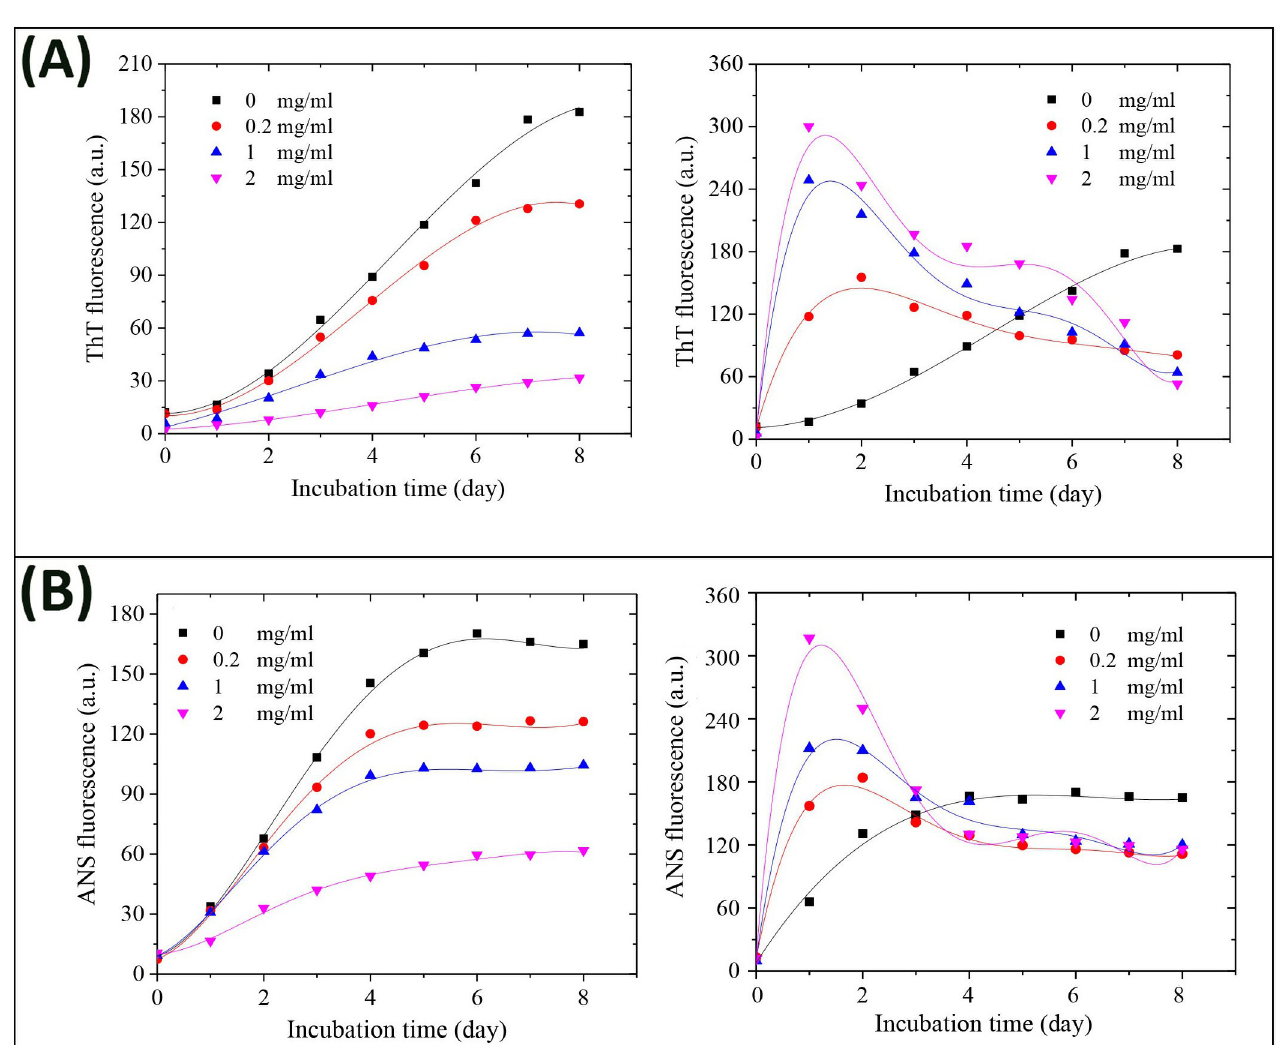
Fig 7. Effect of GOQDs and rGOQDs on the kinetics of amyloid fibrillation (A) and surface hydrophobicity (B) of HEWL as monitored by ThT and ANS fluorescence assays, respectively. Protein samples (50 μ M) were incubated in 50 mM glycine (pH 2.2) at 57 � C either alone or with various concentrations of GOQDs (left graphs) or rGOQDs (right graphs) and fluorescence intensity was measured for 8 days. Each experiment was performed in triplicate.